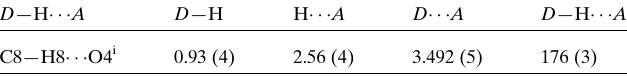
Table 2 Hydrogen-bond geometry (A˚ , (cid:2) ).